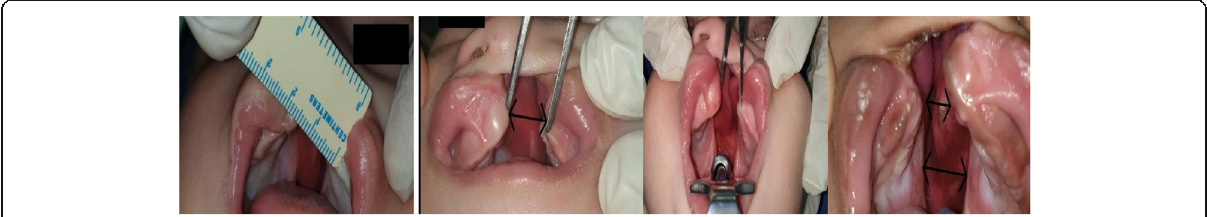
Fig. 3 Different methods for measuring the specified dimensions